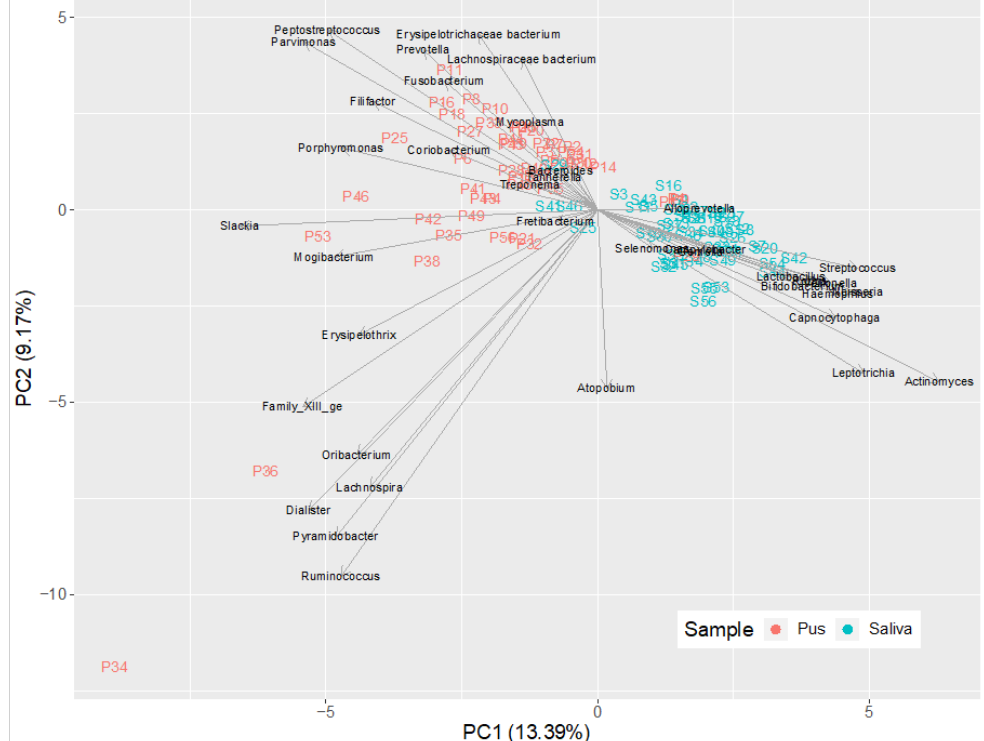
Figure 9. Principal component analysis biplot of all saliva and pus samples ( n = 100; sum of rows > 20%) in order to visualize the relationship between the bacterial genera and the distances between samples (beta diversity). As can be seen, there is almost a complete separation of the samples (saliva and pus).